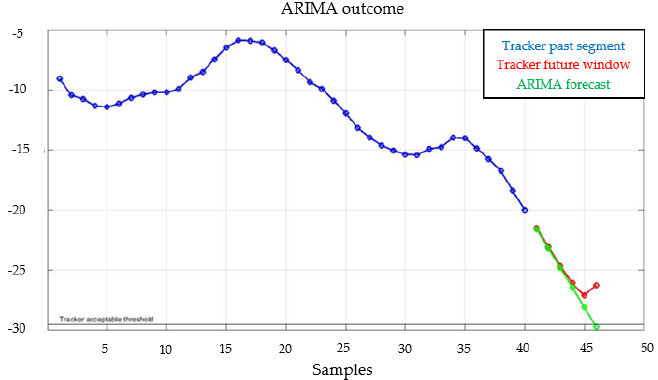
Figure 12. Algorithm’s forecast (green line) against real tracker behavior (red line), when the valve starts wearing (sample 210 of tracker time series). The passing of tracker acceptable threshold determines the warning given by the code.